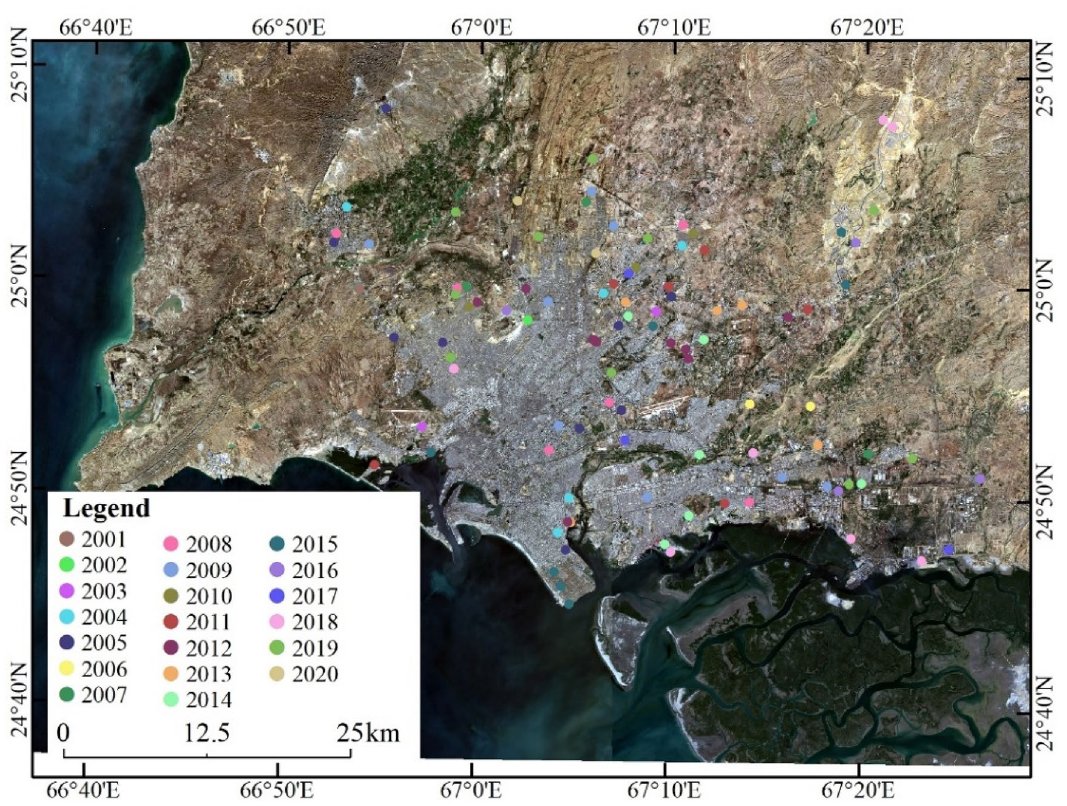
Figure 10. Distribution of ground sample points from 2000 to 2020 (the map created in ESRI ArcMap 10.2, https:// suppo rt. esri. com/ zh- cn/ produ cts/ deskt op/ arcgis- deskt op/ arcmap/ 10-2-2). Image data source: Landsat OLI image (2020) from